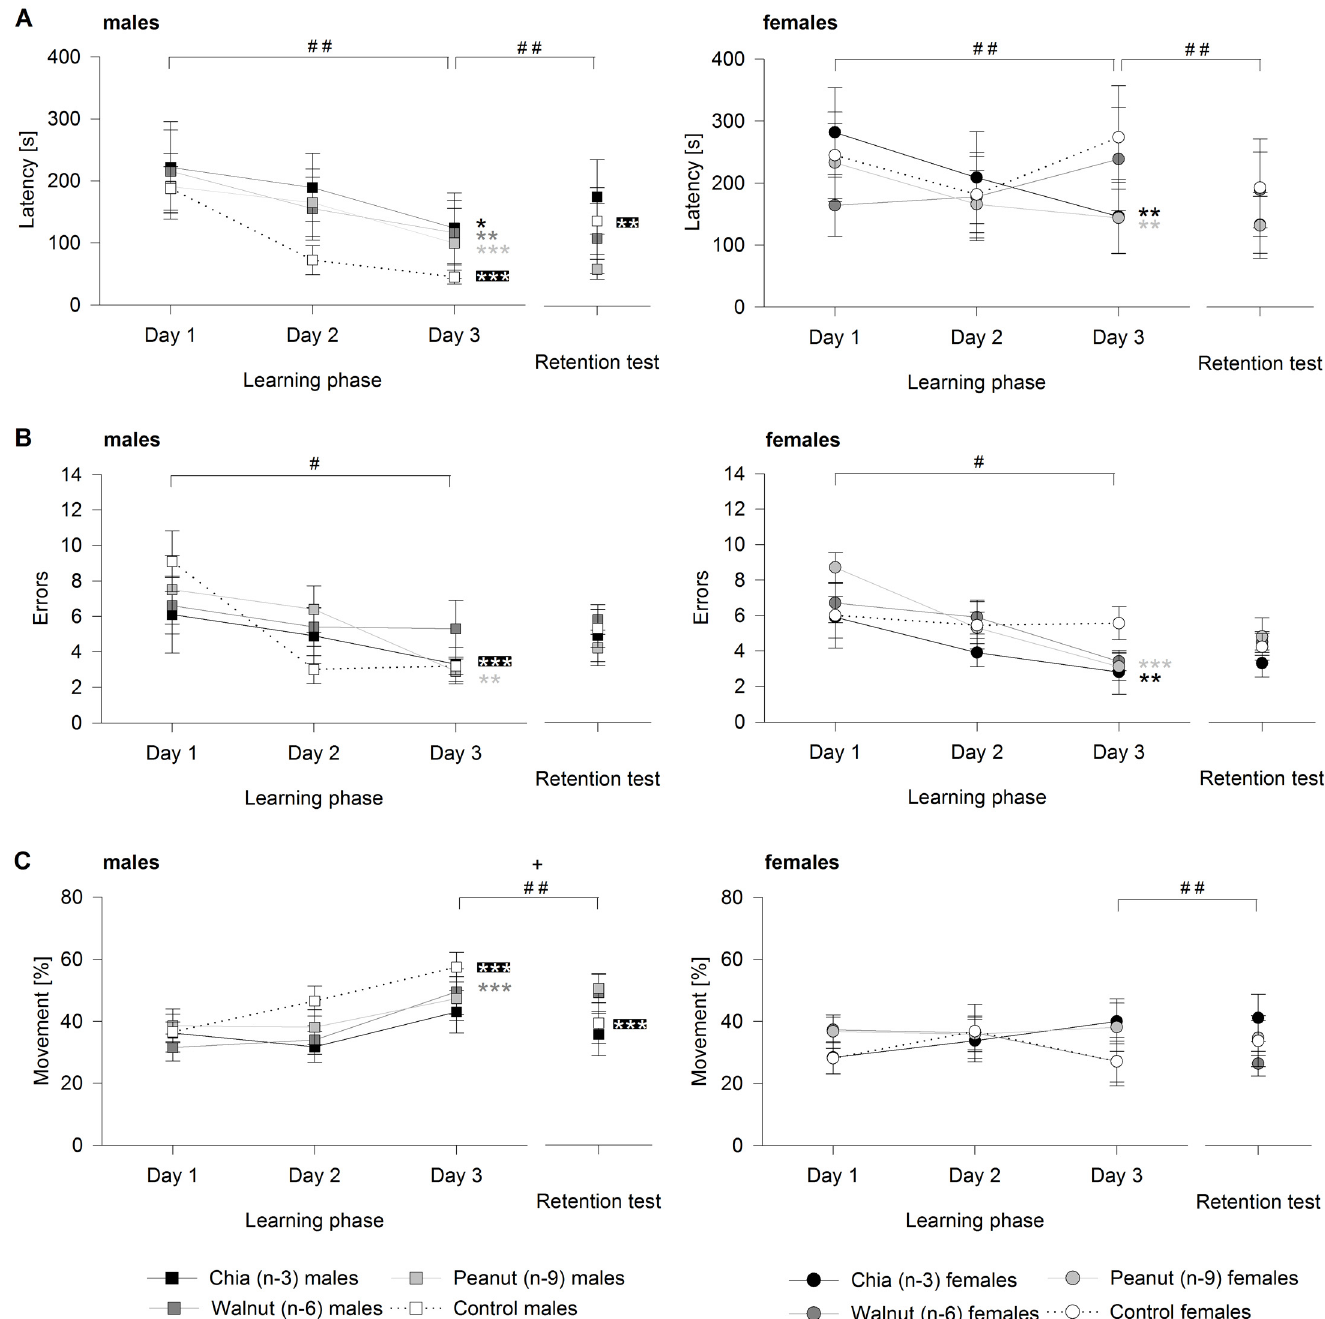
Fig 2. Behavior of male and female groups during the spatial cognition test. (A) Latency time to pass the test for males and females. (B) Number of conducted errors for males and females until the test was passed. (C) Percentage of movement for males and females until the test was passed. Values are means ± SEM. Asterisks next to the symbols on day 3 of the learning phase indicate significant changes in the time course throughout the learning phase for single male and female groups; asterisks next to the symbols of the retention test indicate significant changes compared to day 3 of the learning phase for single male and female groups: * p (cid:1) 0.05, ** p (cid:1) 0.01, *** p (cid:1) 0.001 (chia, walnut, peanut, control). Significant differences in the time course between single male and/or female groups throughout the learning phase, as well as from day 3 of the learning phase to the retention test are indicated as following: # p (cid:1) 0.05, ## p (cid:1) 0.01 comparing control males and control females; + p (cid:1) 0.05 comparing control males and peanut males.